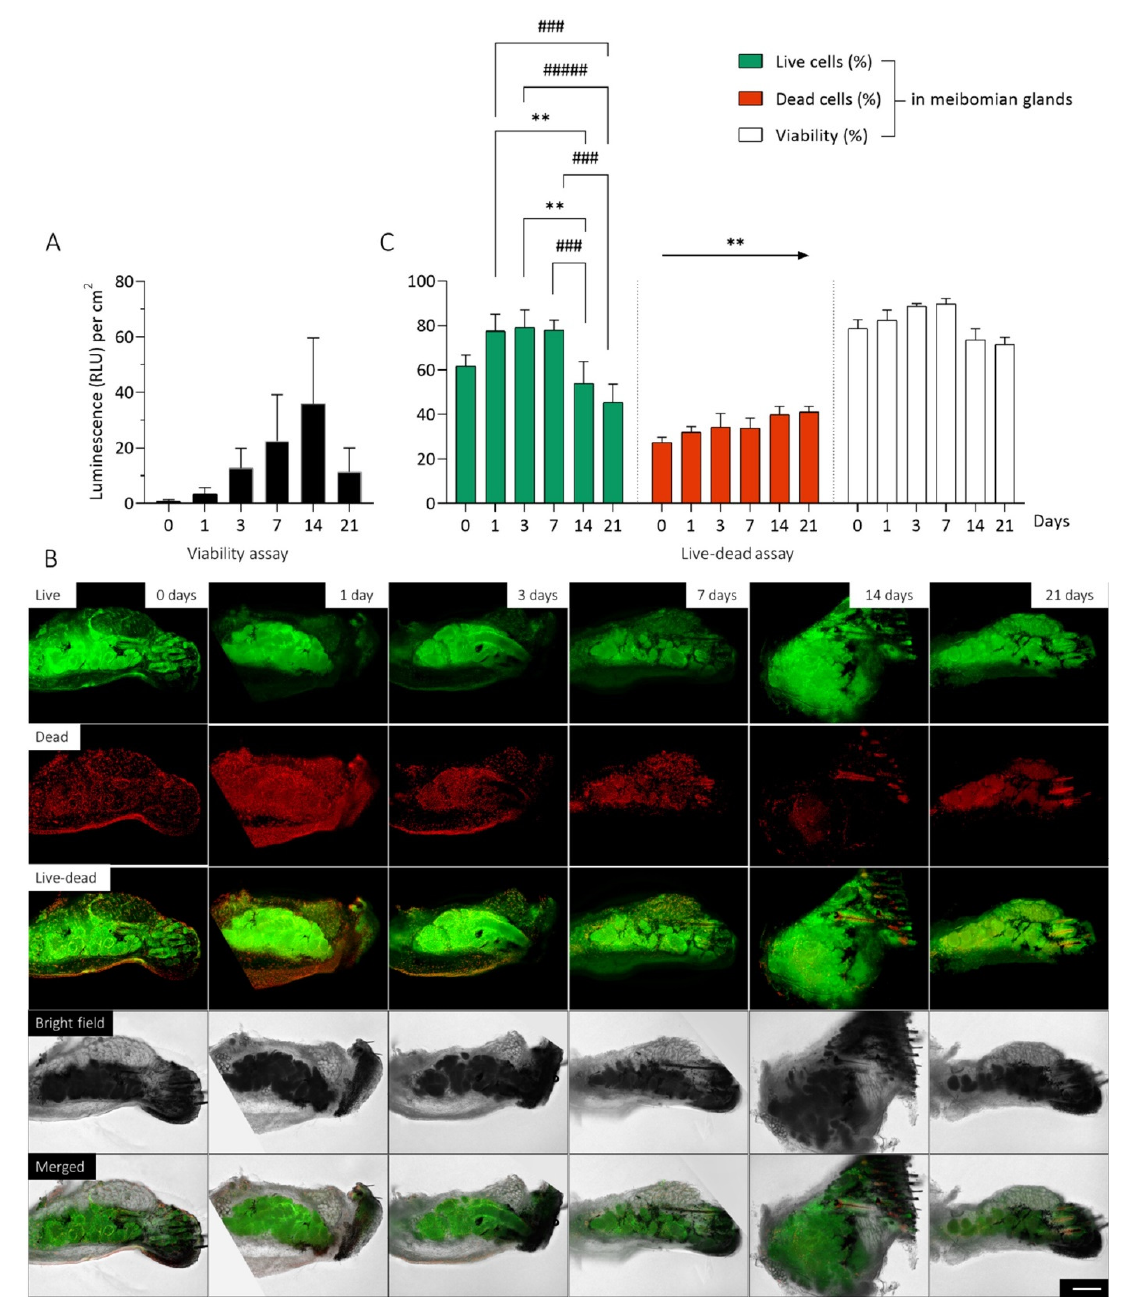
Figure 1. Viability of organotypic slice cultures (OSC) of mouse meibomian glands (mMG) over 21 days. The viability of mMG OSCs were investigated over 21 days. No decrease in viability was observed within the first 14 days of cultivation ( A ). Representative pictures of OSCs after live-dead staining illustrates the location and distribution of the live (green) and dead (red) cells. Bright field imaging shows the position of the mMGs within the OSC ( B ). The evaluation of live-dead images based on the proportion of live and dead cells and the viability of mMG during the cultivation period ( C ). Most of the live cells are located in the meibomian glands, while the dead cells are homogeneously distributed throughout the tissue. Data are n = 9 ( A ) and 4 ( B , C ), mean ± SEM. Significant changes compared to day 14 are assigned as */compared to day 21 are assigned as #. An arrow indicates a linear trend test. ** p ≤ 0.01, ### p ≤ 0.001, ##### p ≤ 0.0001 ( C ). Scale bar: 200 µm ( B ).